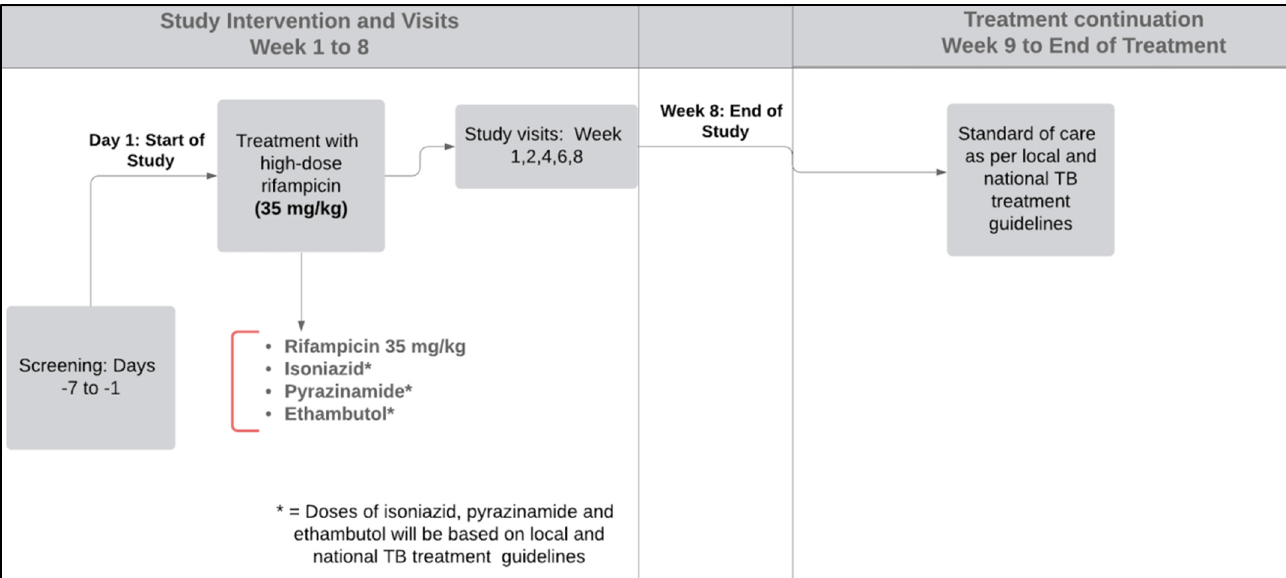
Figure 1. Study flow diagram.